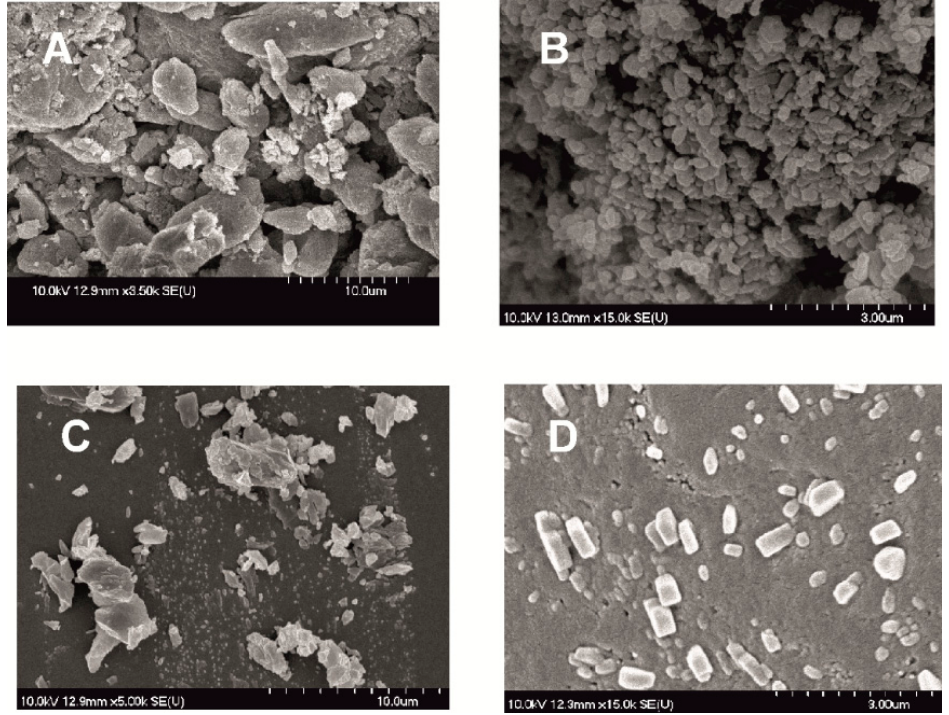
Figure 4. SEM pictures of MEL_raw ( A ); MEL_W 10 min ( B ); MEL_W_PVA 10 min ( C ) and MEL_W_PVA 50 min ( D ).